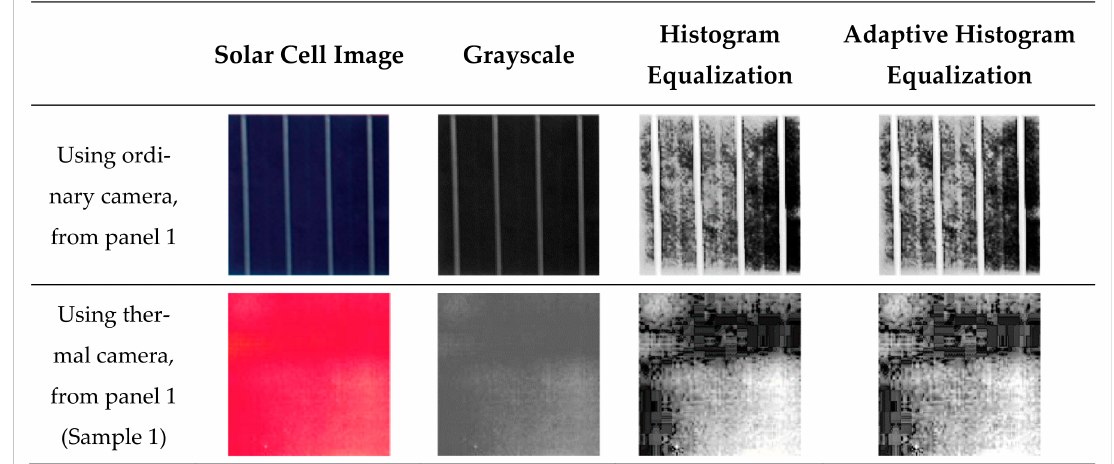
Figure 11. Results of the processed images using grayscale, histogram equalization, and adaptive histogram